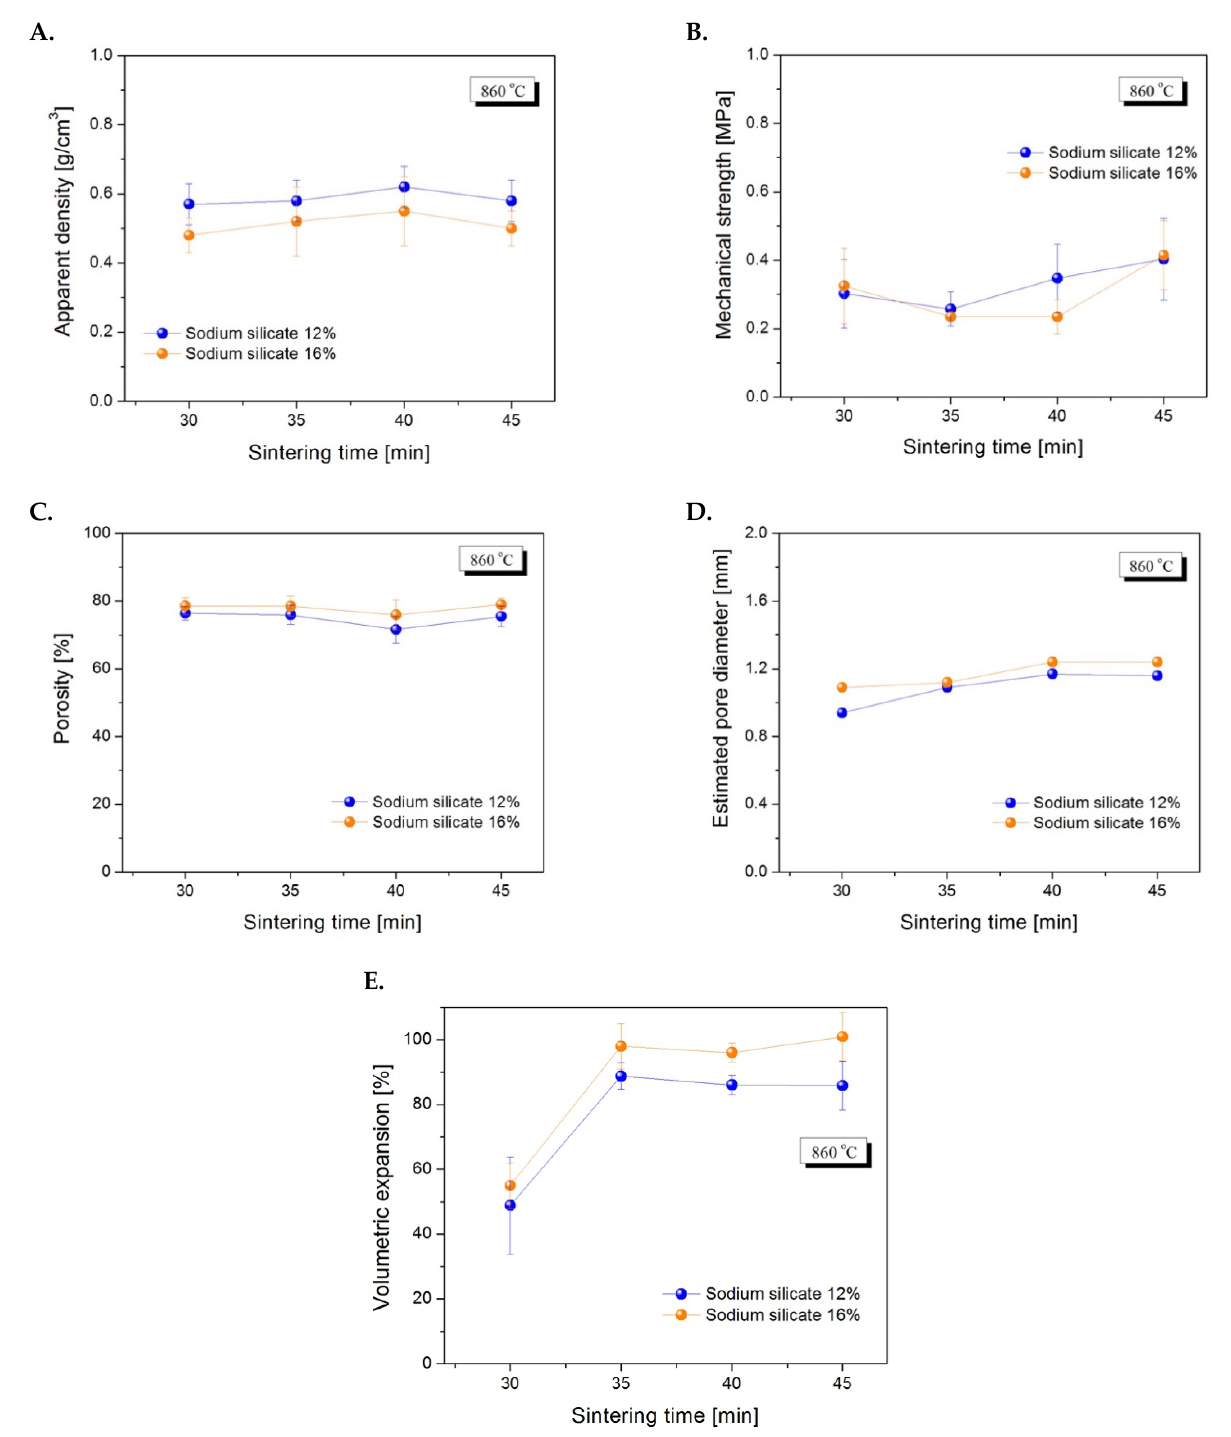
Figure 8. Effect of the sintering time in the characteristics of the ceramic foams obtained at 860 ° C: apparent density ( A ), mechanical strength ( B ), porosity ( C ), pore diameter ( D ) and volumetric expansion ( E ).